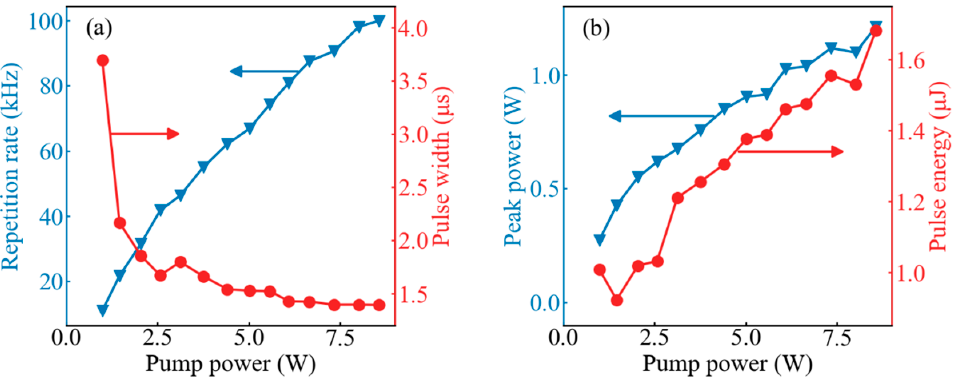
Figure 4. (a) Repetition rate (triangle) and pulse width (circle) as a function of pump power. (b) Peak power (triangle) and pulse energy (circle) as a function of pump power.